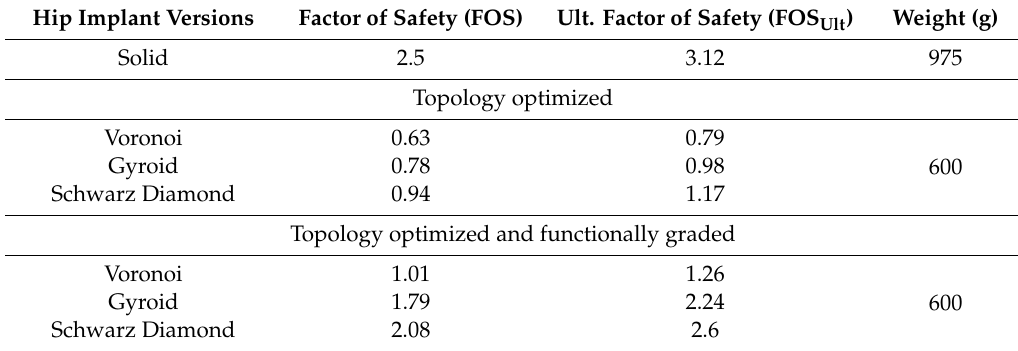
Table 6. Factor of safety for all examined versions of hip implant’s